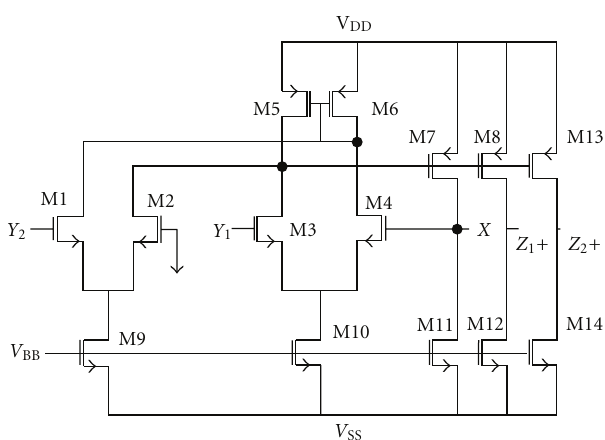
Figure 2: CMOS implementation of DVCC with two Z +